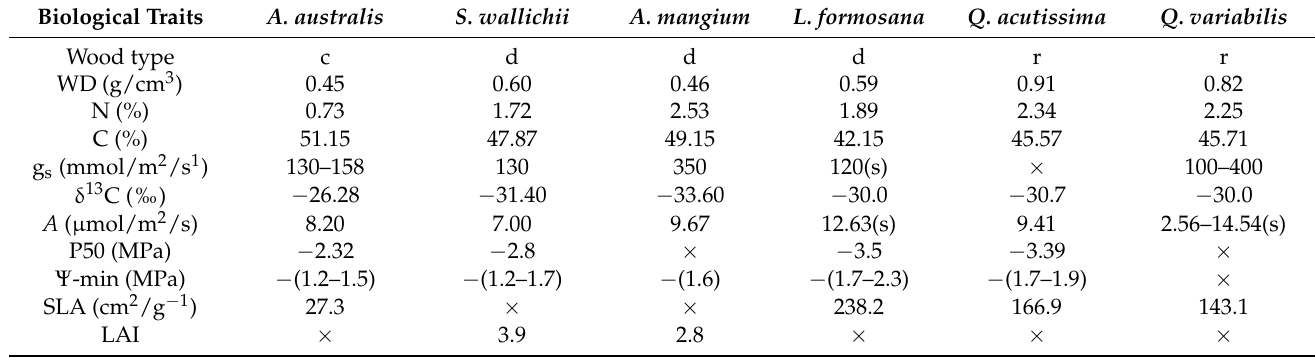
Table 2. Biological traits for six species used in this study. Wood density (WD), leaf nitrogen content (N) and carbon content (C), leaf stomatal conductance (g s ), leaf carbon isotope ratio ( δ 13 C), photosynthetic rate ( A ), xylem water potential at 50% loss of hydraulic conductance (P50), minimum leaf water potential ( Ψ -min), specific leaf area (SLA), the maximum leaf area index (LAI) are shown. Letter ‘ s ’ represents data from seedlings. Letters c, d and r represent conifer, the diffuse porous and ring porous wood characteristics respectively. An x represents no data